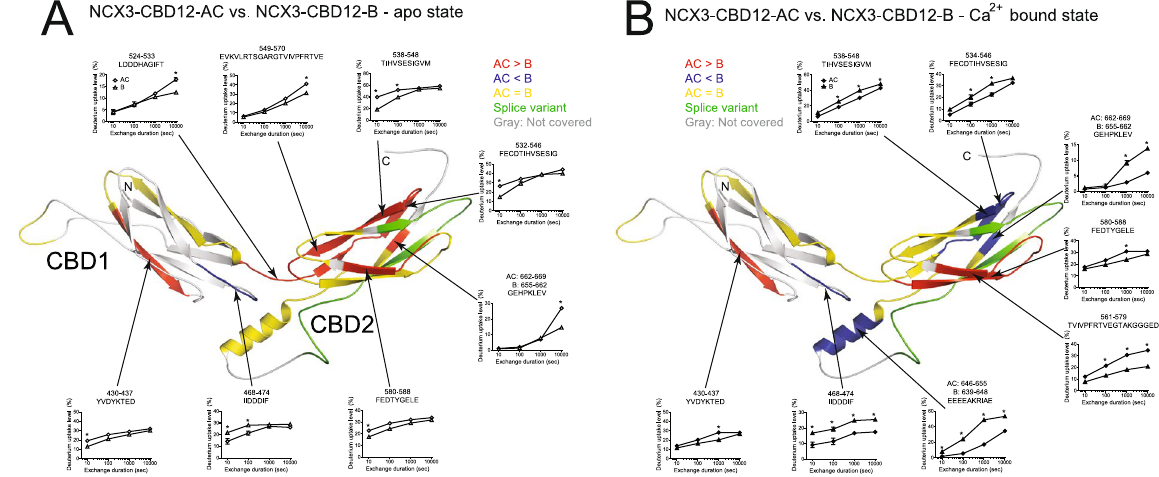
Figure 4. Effect of alternative splicing on the conformational dynamics of NCX3-CBD12. Deuterium uptake differences between NCX3-AC and NCX3-B in the apo form ( A ) or in the Ca 2 + -bound form ( B ) are color- coded onto the model of NCX3-AC. Regions with similar deuterium uptake are yellow, regions with higher deuterium uptake in NCX3-AC are red, and regions with higher deuterium uptake in NCX3-B are blue. The alternative splicing region is in green and regions not covered by the detected peptic peptides are in gray. The uptake plots of the indicated peptic peptides are presented. Error bars represent SEM, * indicated p < 0.05 as analyzed by t-test.